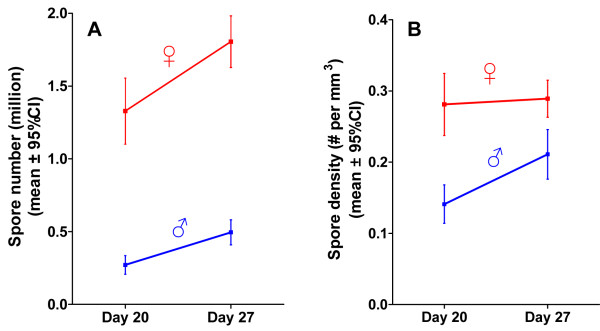
Number and density of parasite spores in male and female hosts, 20 and 27 days post-exposure. The P. ramosa spore number (A) and the density (B) were higher in females D. magna than in males. Error bars represent the 95% confidence intervals.